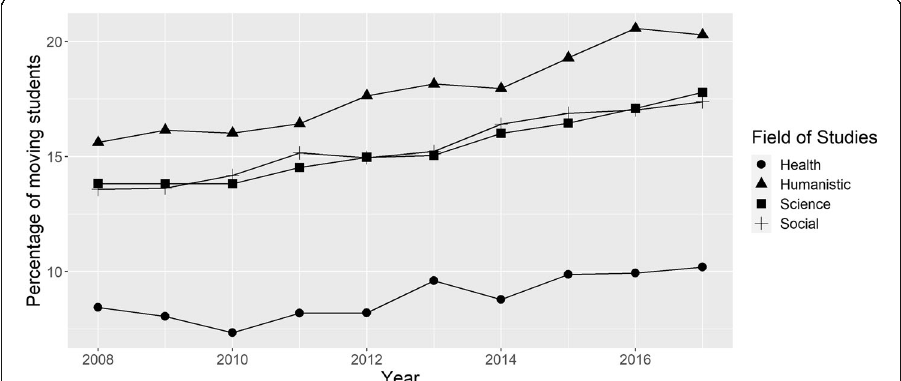
Fig. 3 Rates of total mobility ( movers plus half movers ) by field of study (2008 –